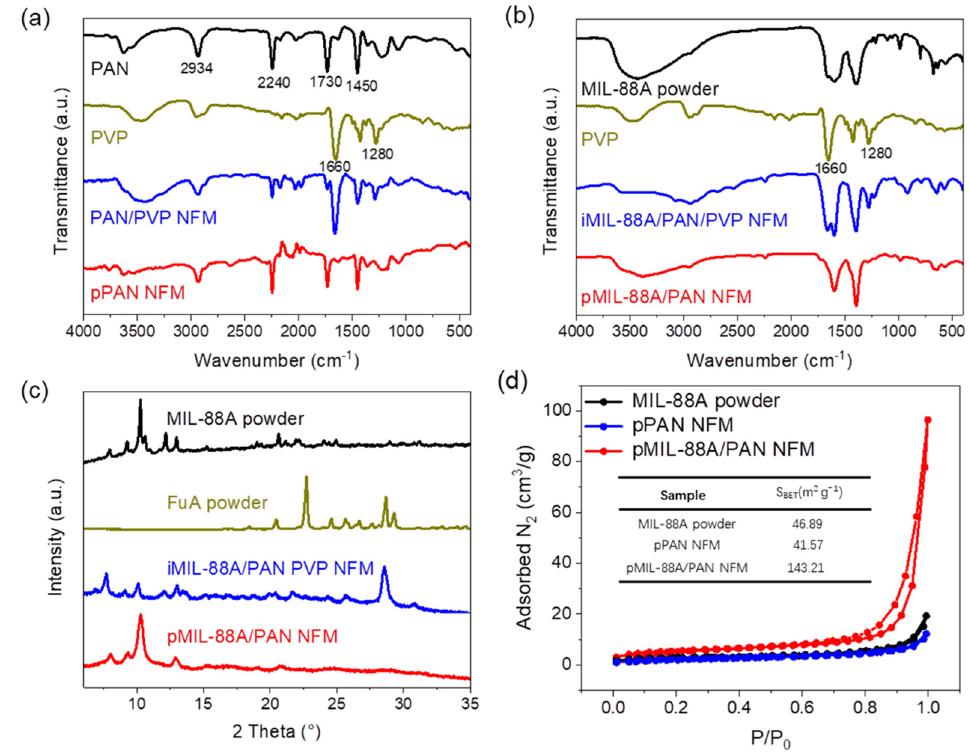
Figure 3. FT − IR spectra ( a , b ) and XRD patterns ( c ) of the relevant samples. ( d ) N 2 adsorption − desorption isotherms of the MIL-88A powder, pPAN and pMIL-88A/PAN NFMs; BET surface areas in the inset.